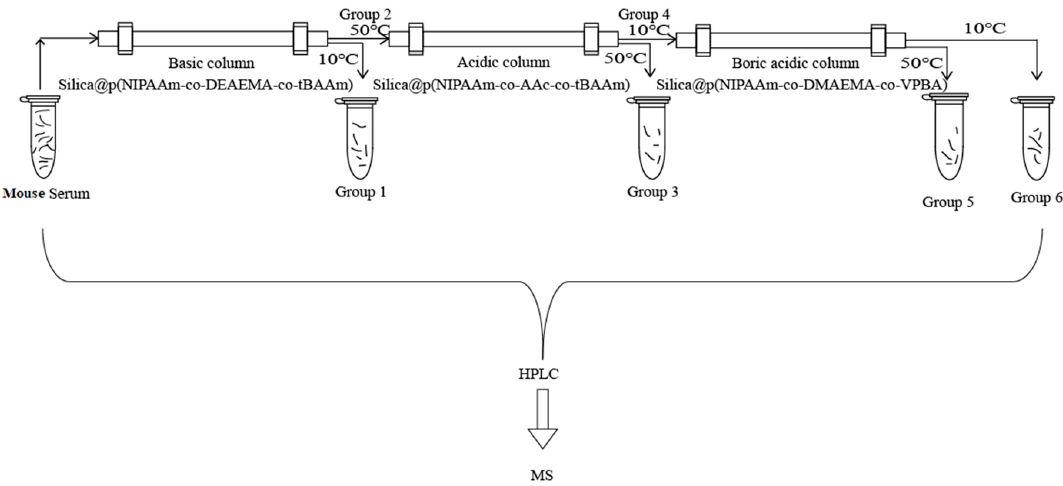
Figure 8. Workflow for the proteomics of mouse serum using three thermal-responsive silica materials.